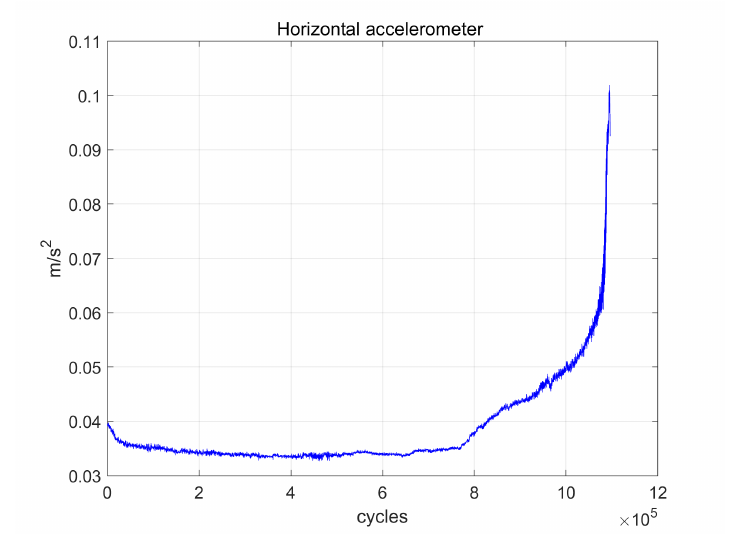
Figure 16. RMS value of the horizontal acceleration of the nut A .